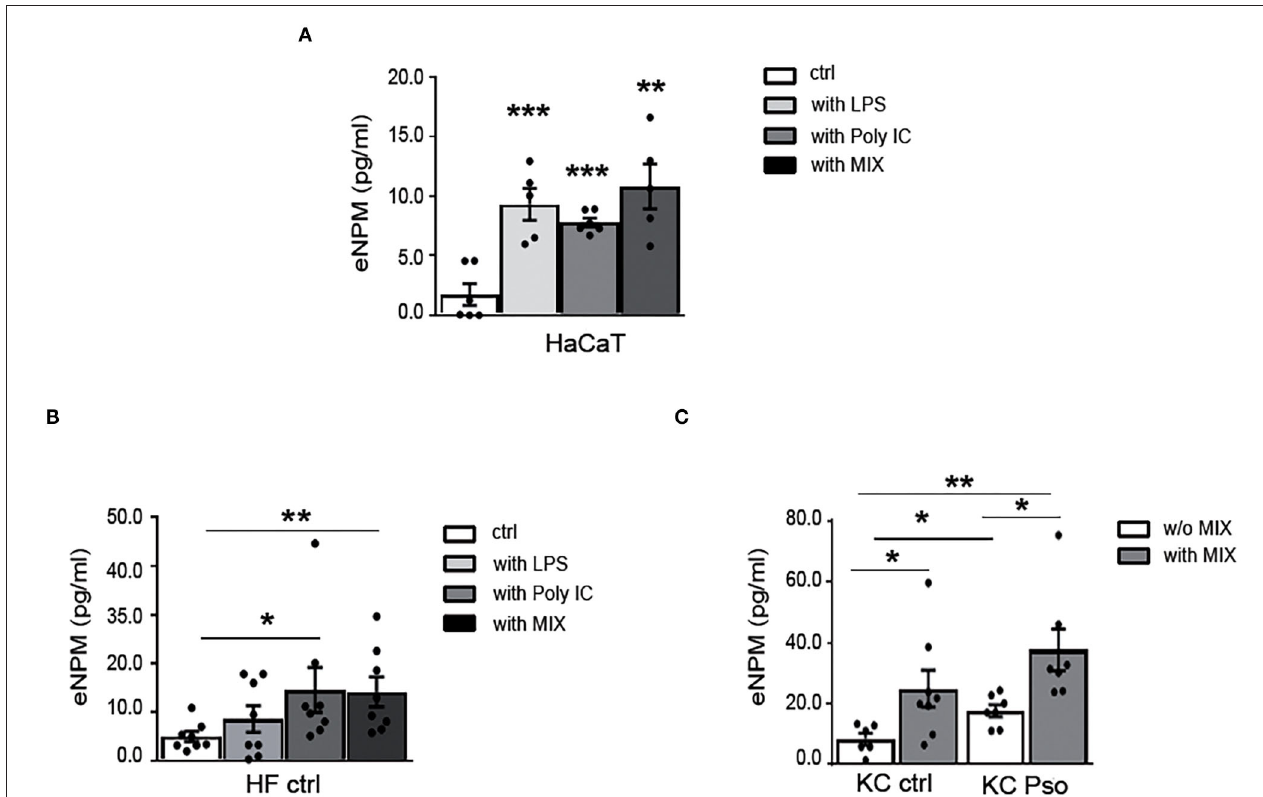
FIGURE 3 | eNPM is rapidly secreted in the extracellular space by HaCaT, KCs, and HFs upon different inflammatory stimuli. (A) HaCaT were either serum starved for 8h or treated with 100 µ g/ml LPS, or 0.5 µ g of Poly I:C (HMW e LMW), or with a MIX of cytokines (IL-17A, IL-22, TNF α , and IFN γ ). Extracellular NPM levels (eNPM) were quantified by ELISA assay ( n = 5; ** p < 0.01, *** p < 0.001). All the treatments induced an increase eNPM compared to starvation. (B) HFs of healthy subjects were either serum starved for 8h, or treated with 100 µ g/ml LPS, or 0.5 µ g of Poly I:C (HMW e LMW), or with a MIX of cytokines (IL-17A, IL-22, TNF- α , and IFN- γ ). eNPM levels were quantified by ELISA assay ( n = 8; * p < 0.05, ** p < 0.01). Poly I:C and cytokine MIX increased eNPM significantly in the supernatants. (C) Healthy KCs and KCs of NLS of Pso were either serum starved or treated with a MIX of cytokines for 8h. eNPM was quantified using a specific ELISA assay ( n = 6; * p < 0.05, ** p < 0.01). eNPM was increased in the supernatants of KCs isolated from NLS of Pso and in healthy KCs treated with the cytokine MIX compared to serum-starved healthy KCs supernatants. eNPM was also increased in the supernatants of KCs of Pso treated with cytokine MIX compared to serum-starved KCs of NLS of Pso